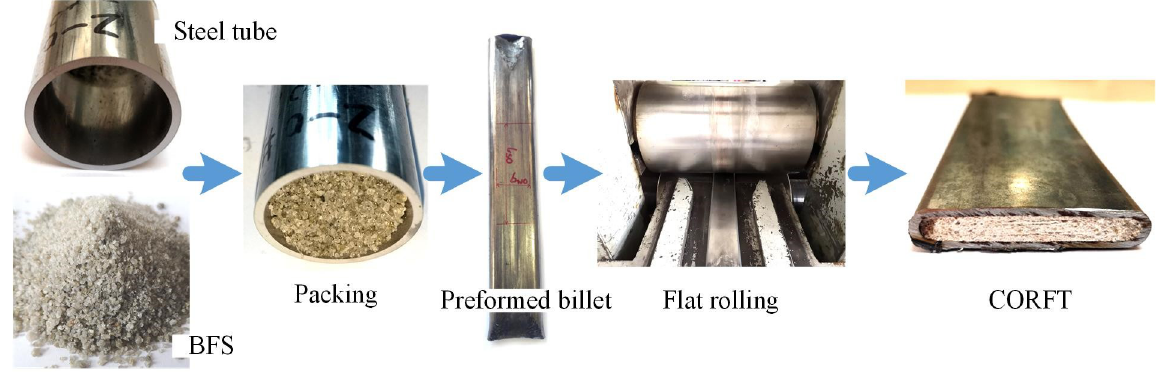
Fig 6. Experimental procedure of the